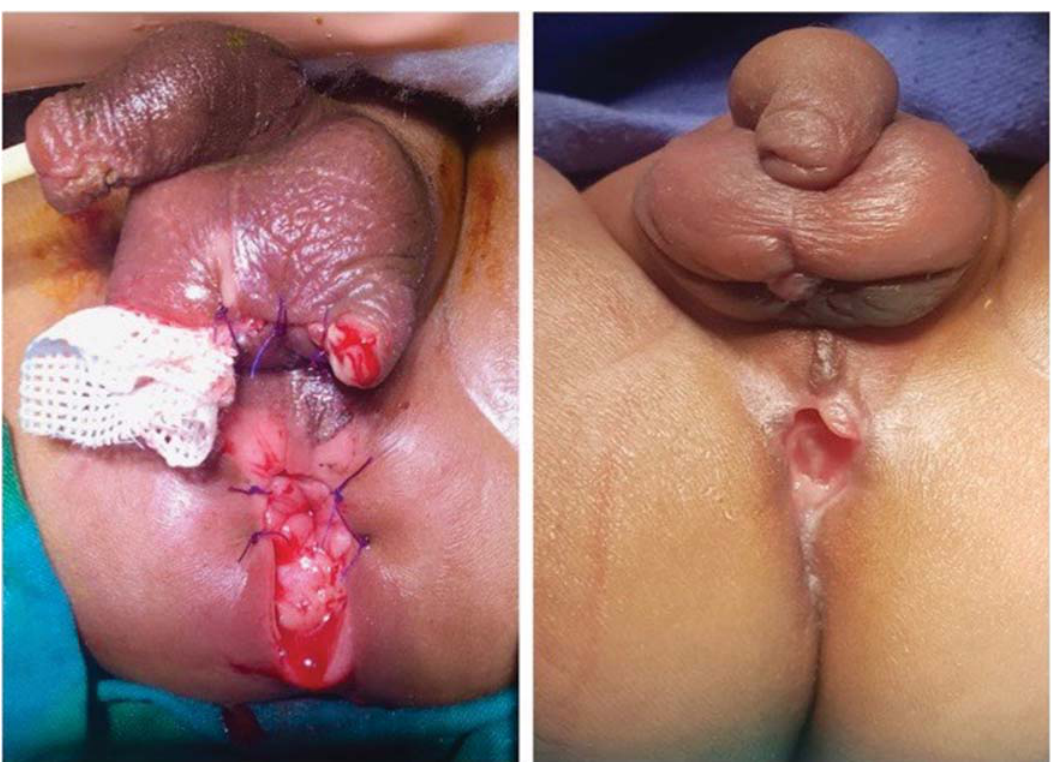
Fig. 6 Case 2. Left: features of the perineum and scrotum 72 hours after the extraperitoneal rectal perforation (after the second debridement). Right: perineum and scrotum 6 weeks after the